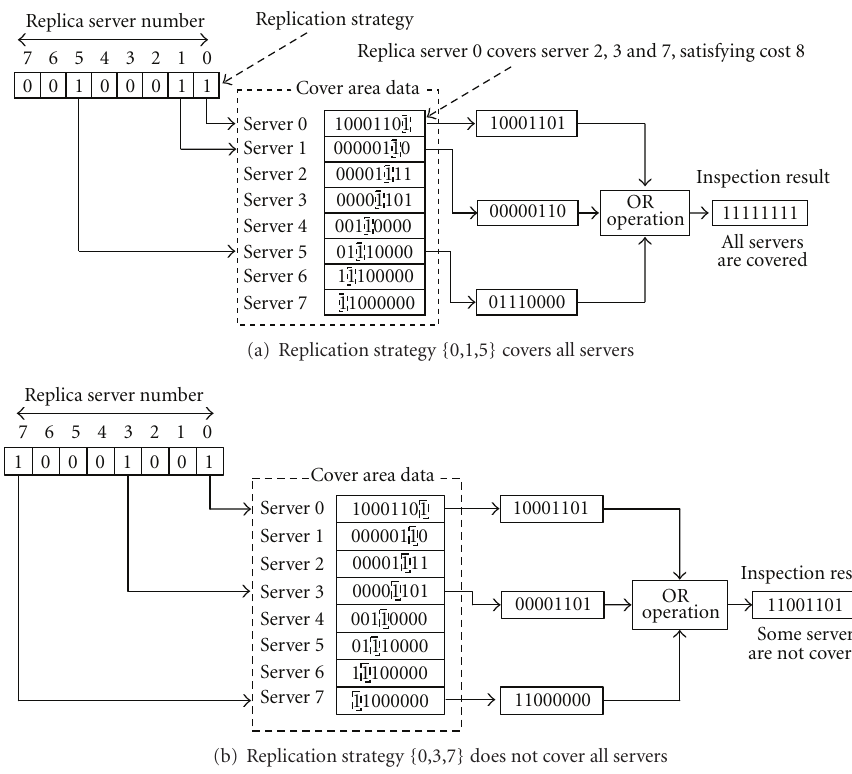
Figure 6: The cover inspection of replication strategies satisfying cost 8.